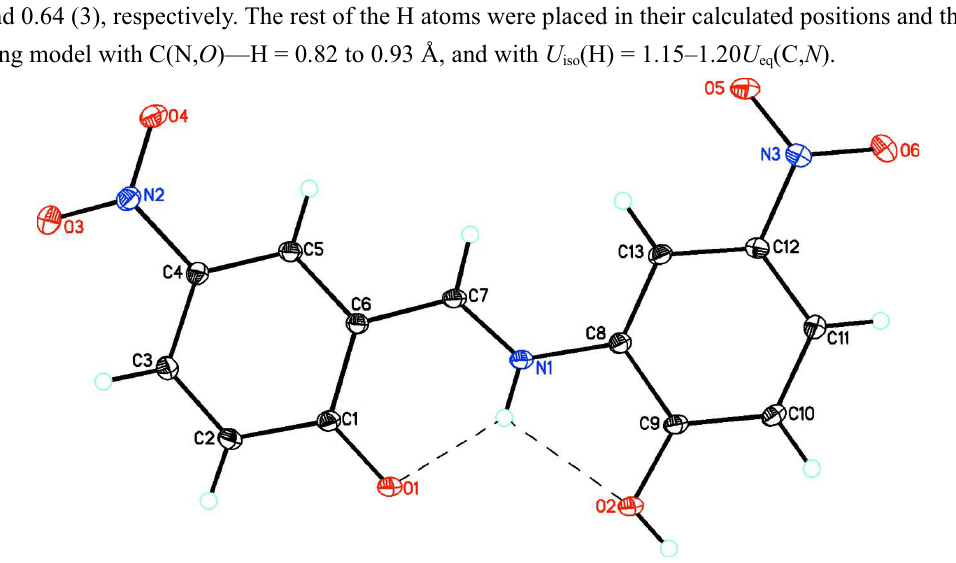
H N O , showing the atom numbering scheme and 50% probability displacement 13 9 3 6